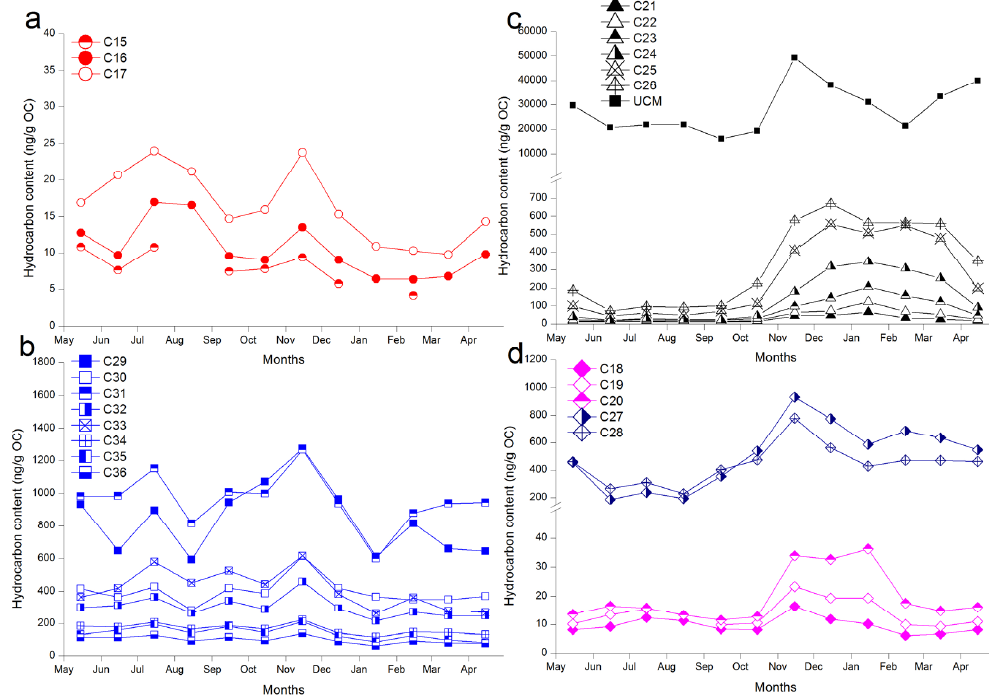
Figure 9. Temporal variations in individual hydrocarbon TOC normalized contents of ambient air aerosols in south coastal Xiamen. ( a ) short-chain homologs; ( b ) long-chain homologs; ( c ) middle-chain homologs plus UCM; and ( d ) Mixture-chain homologs.